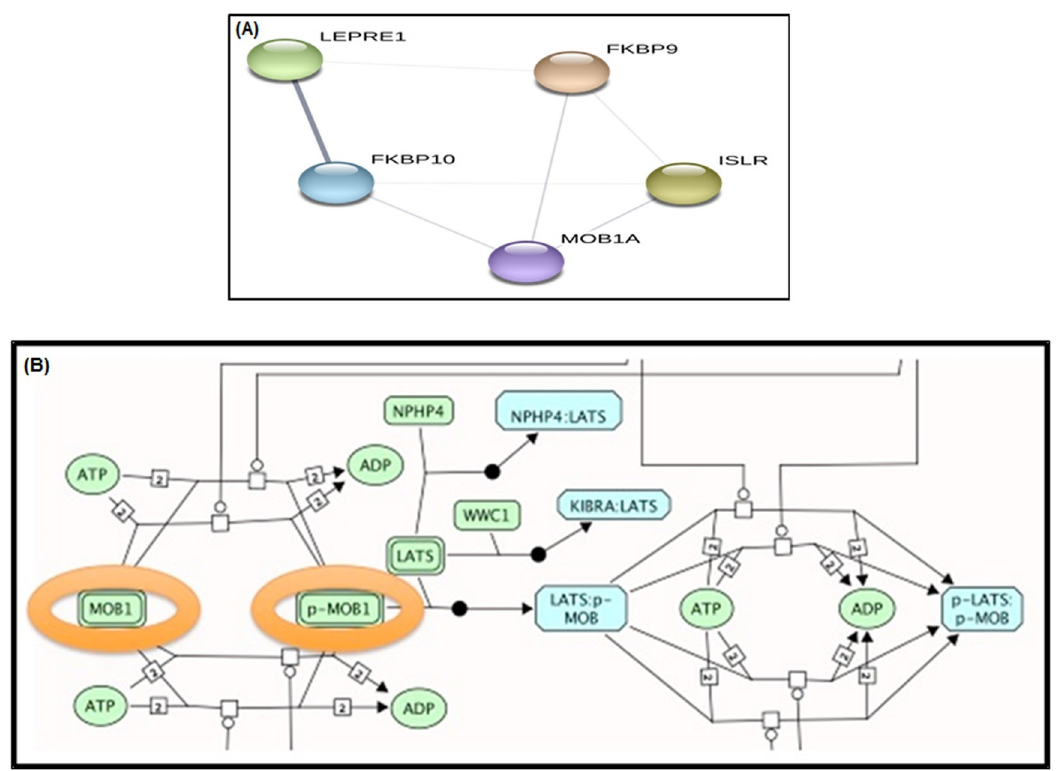
Fig 8. (A) Functional network of proteins in stage 3 breast cancer samples. (B) Molecular pathway of the proteins in stage 3 breast cancer samples, as predicted by STRING.